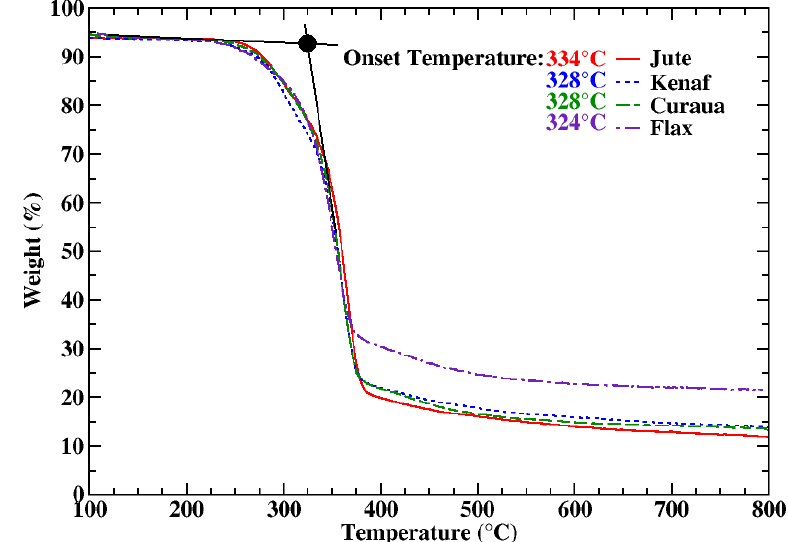
Figure 2. TGA curves of jute, kenaf, curaua, and flax fibres as a function of temperature. Onset temperatures of the fibres are shown as insets.